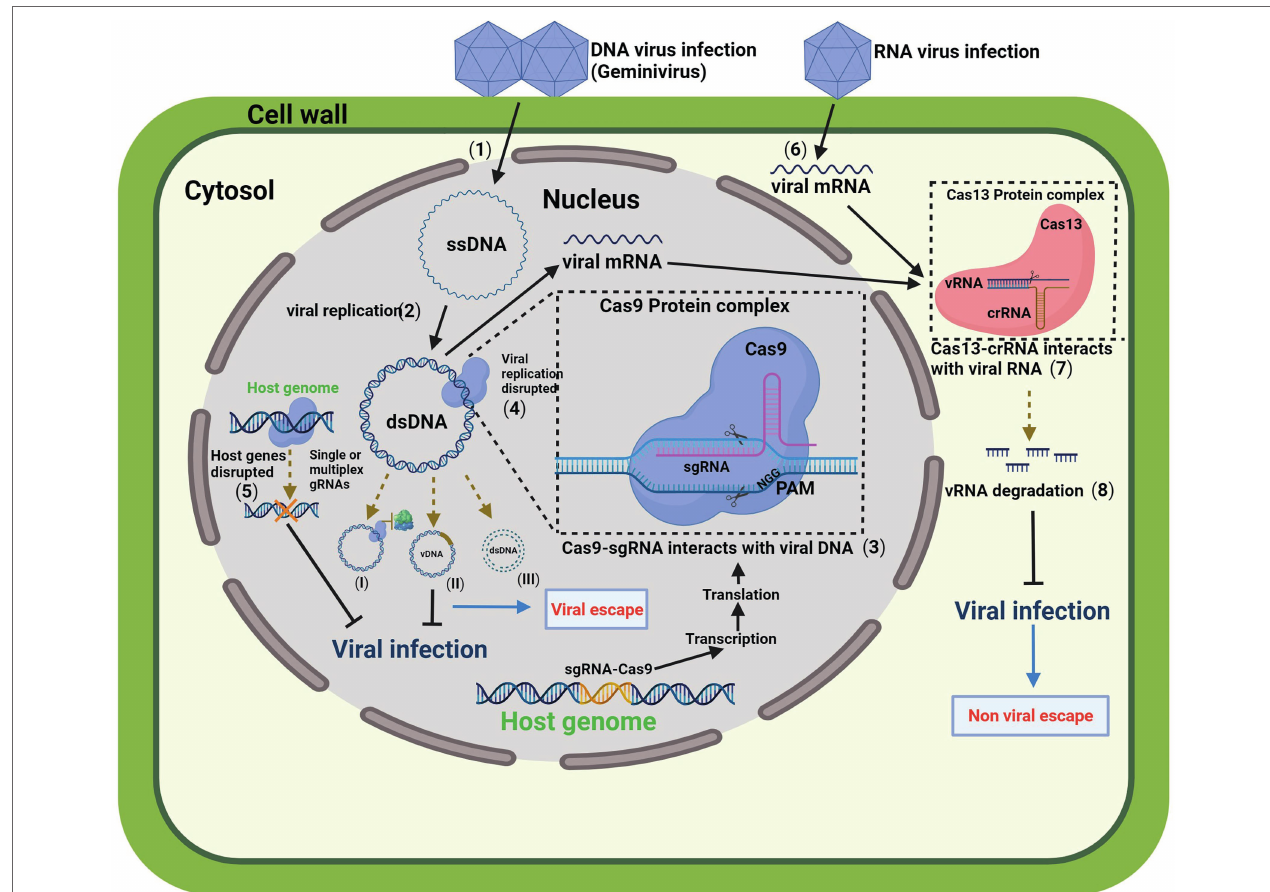
FIGURE 1 | A schematic model for engineering resistance to plant viruses provided by the clustered regularly interspaced short palindromic repeats (CRISPR)/ CRISPR-associated protein (CRISPR/Cas) systems. Plant genome transformed with CRISPR/Cas9 system expresses a functional Cas9 protein complex Cas9/ gRNA. After Geminivirus infection (1), the viral single-stranded DNA (ssDNA) is delivered into the cytoplasm and translocated to the nucleus. The host nuclear machinery assists the complementary strand synthesis resulting in the viral replication to double-stranded DNA (dsDNA) (2), producing multiple viral copies. The Cas9 protein complex Cas9/gRNA binds to the viral genome (3), which is assisted by a short sequence of 20 nucleotides that directs the Cas9 endonuclease to a specific region of the genomic DNA where it acts as a molecular scissor. A protospacer adjacent motif (PAM) is required. The action of Cas9 results in a double- strand break, and virus replication is disrupted by preventing access to replication proteins (4; I), introducing pinpoint mutations in the viral genome (II), or disrupting the genome by cleavage of dsDNA (III). The CRISPR/Cas system mutagenic property may generate some viral variants. Alternatively, the Cas9 protein complex with multiple gRNAs can target plant host factors to disrupt genes important for viral replication or movement (5). Combining multiplex CRISPR/Cas systems, such as Cas13 and Cas9, is a possible alternative to avoid viral escapes and targeting RNA viruses. After RNA virus infection (6), the viral mRNA interacts with CRISPR/ Cas13 system through a short CRISPR RNA (crRNA; 7). The Cas13-crRNA complex is RNA-guided RNA-targeted, and the cleavage of the vRNA induces vRNA degradation (8) and disrupts viral infection. The figure was created with BioRender.com. Cas, CRISPR-associated; CRISPR, clustered regulatory interspaced short palindromic repeats; dsDNA, double-stranded DNA; ssDNA, single-stranded DNA; sgRNA, single guide RNA; vDNA, viral DNA; CRNA, CRISPR RNA; ssRNA, single-stranded RNA; tracrRNA, trans-activating crRNA; and PAM, protospacer adjacent